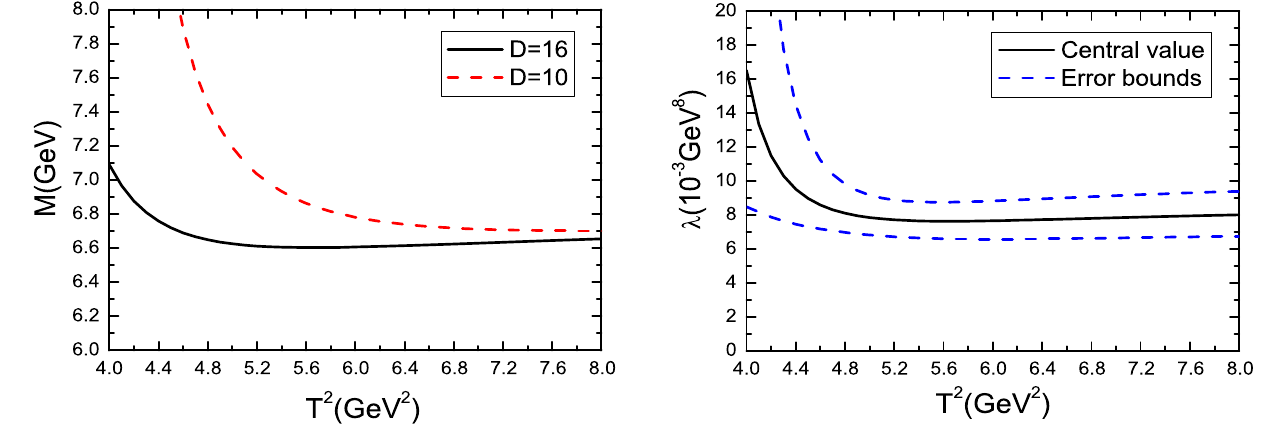
Fig. 7 The pole residue of the Z ++ cc with variation of the Borel param- eter T